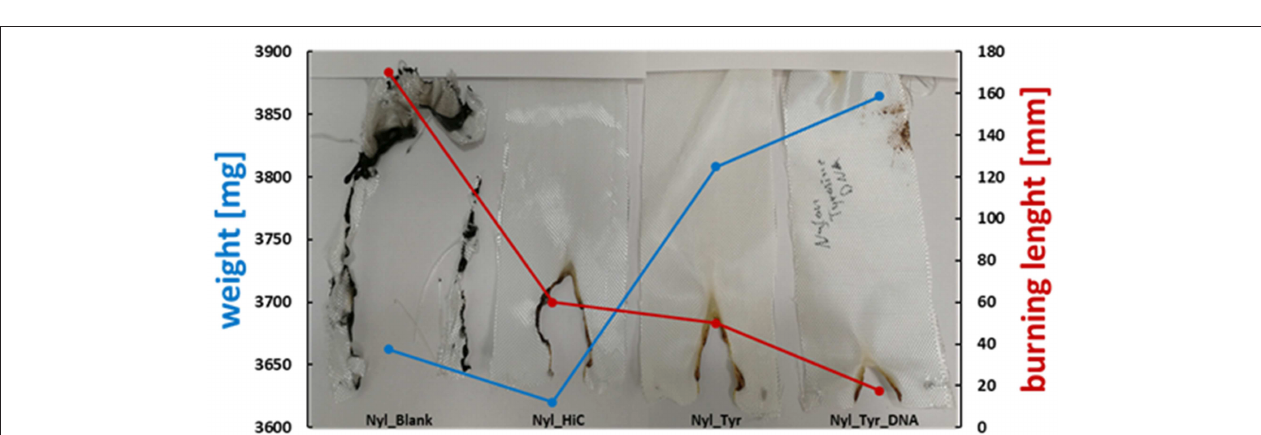
Frontiers in Chemistry |